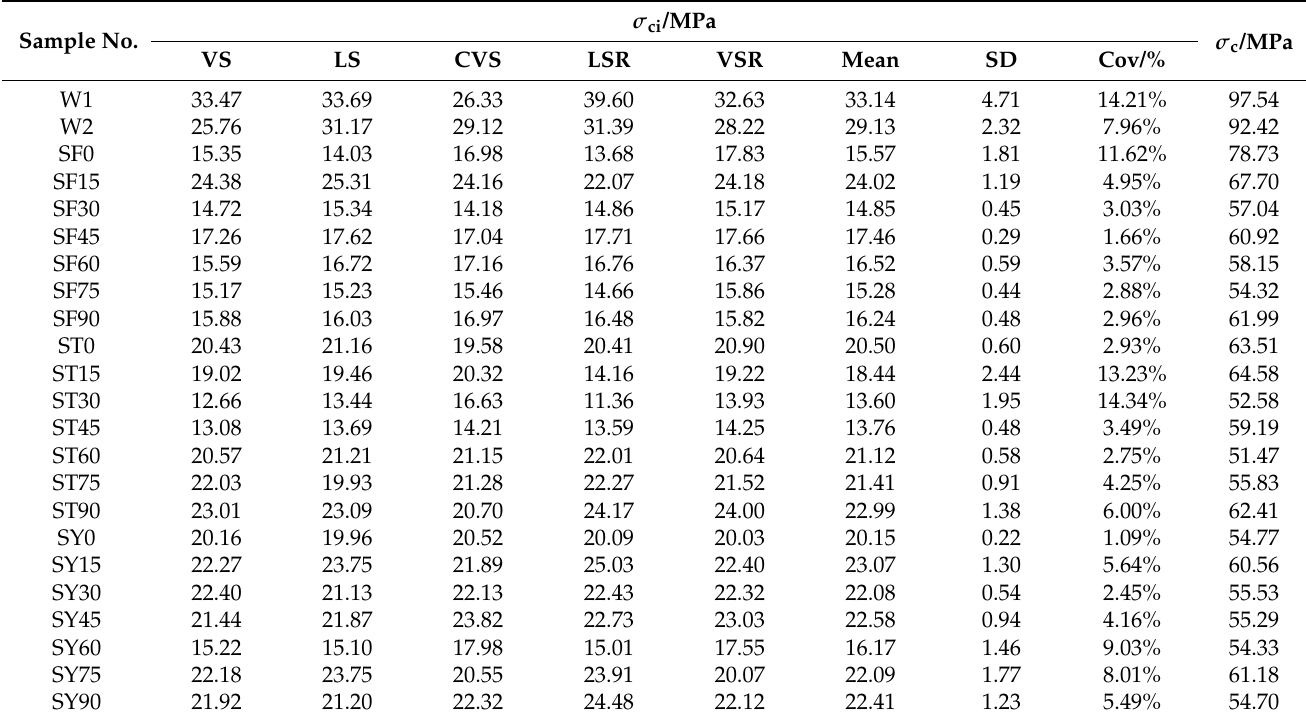
Table 4. Summary of the sandstone progressive failure thresholds σ ci and σ c under hydro-mechani- cal